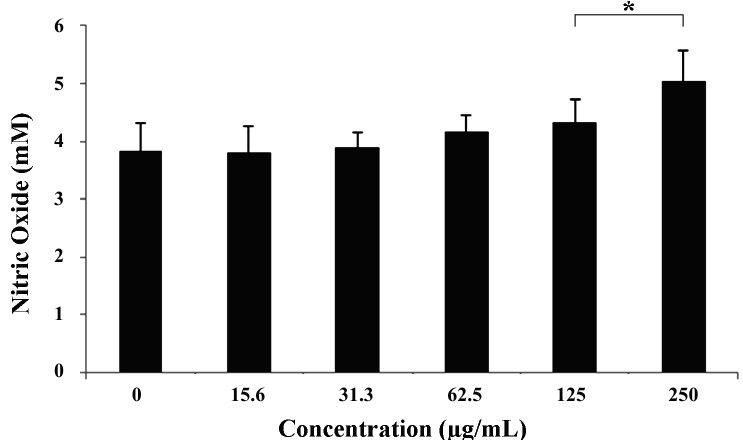
Figure 4. Effect of the DME on the production of nitric oxide (µM) by macrophages.